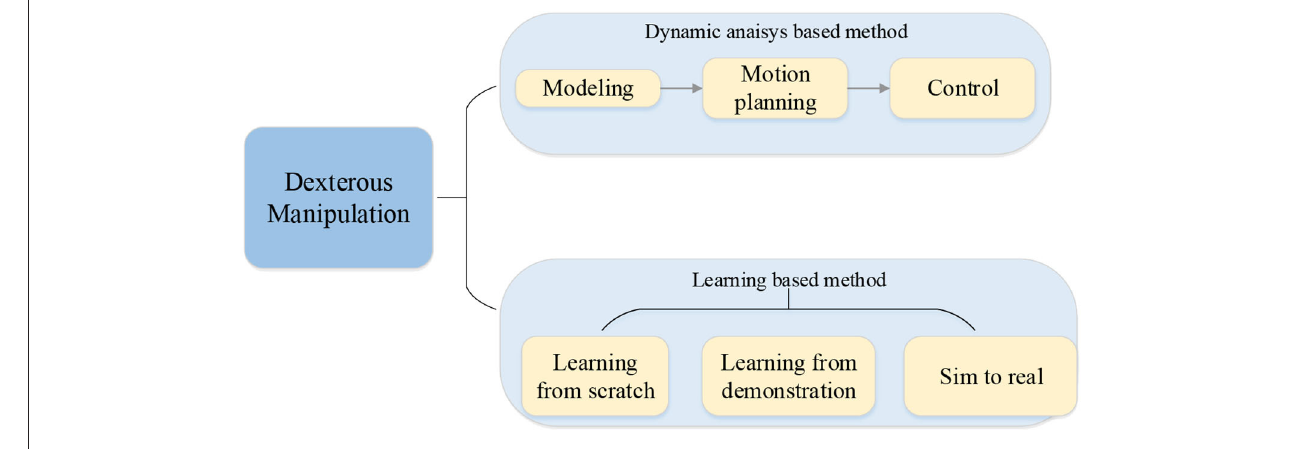
FIGURE 2 | Overall presentation of this work.